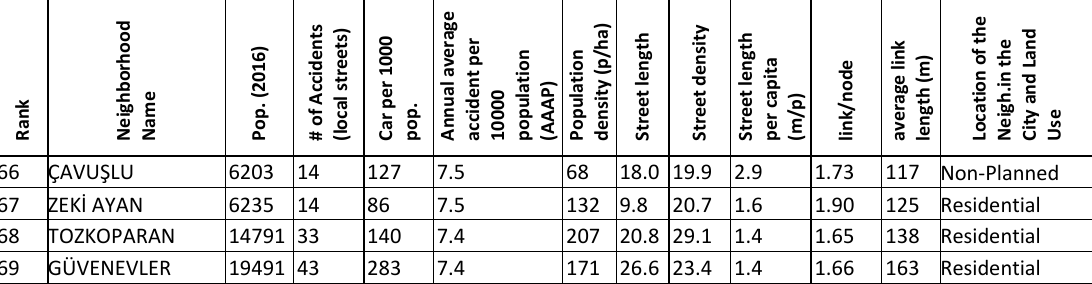
Table 5 Spatial Figures of Safest 20 Neighborhoods (With Lowest Rates of